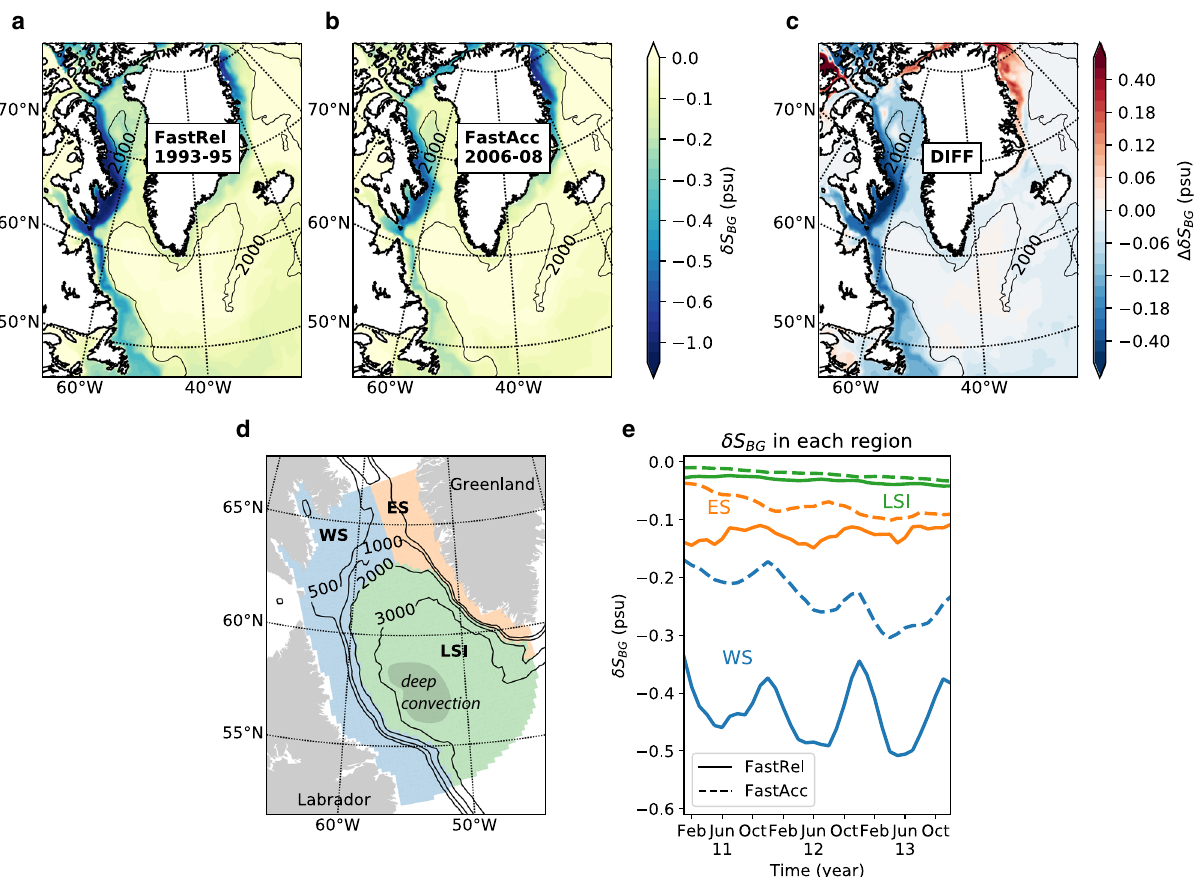
Fig. 4 Impact on downstream salinities. Changes of upper-200-m salinity induced by the Beaufort Gyre-sourced water during the last 3 years of FastRel ( a ), FastAcc ( b ), and the differences (FastRel minus FastAcc) ( c ). Beaufort Gyre-induced salinity changes ( δ S BG ) are estimated as the difference between the local salinity and the salinity of the non-Beaufort Gyre-sourced water, averaged over the upper 200 m (see Methods section). The 2000 m isobath is shown in thin black lines. d The Labrador region is divided into western shelves (WS), eastern shelves (ES), and Labrador Sea interior (LSI), as shown by colors. The 2000m isobath is used to separate the basin interior from the shallower regions. Gray shading in the LSI schemes the main deep convection region as observed. e Monthly δ S BG averaged over the three sub-regions as indicated in d